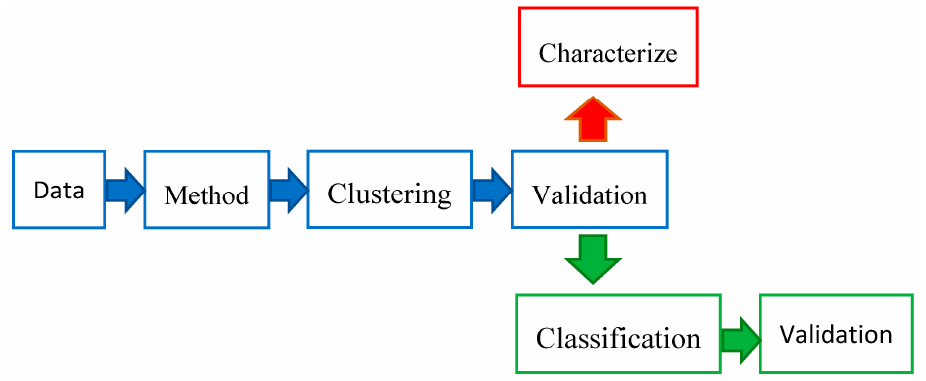
Figure 2. Depiction of standard modelling structure. (Blue) Indicates the elements all papers go through (data, method selection, clustering and validation); (Red) Some papers charachterize the identified clusters, usually applying external data; (Green) Applying the identified clusters to classifify new consumption series to evaluate the applicability of the clusters.